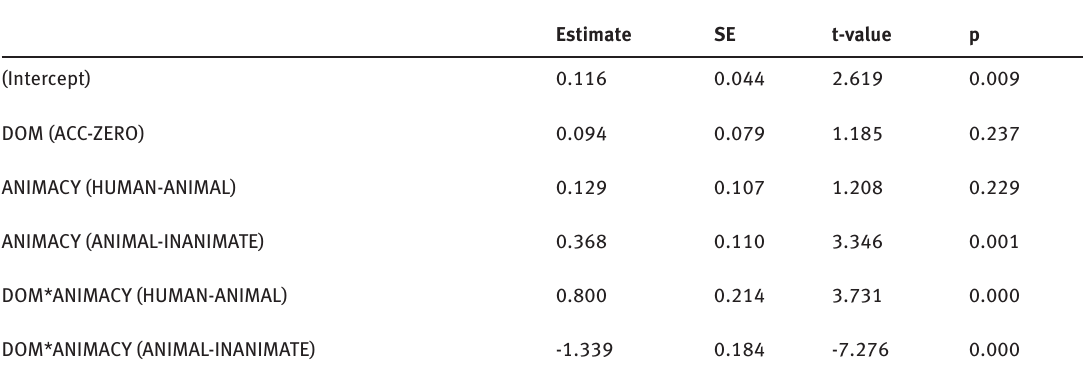
Table 1. lme results for the interaction of DOM and main animacy levels